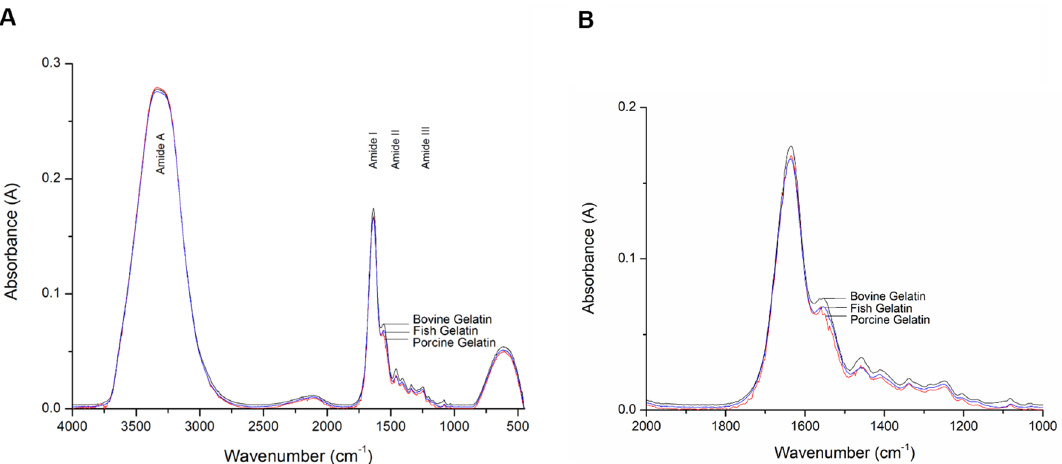
Figure 3. ( A ) Full scale FTIR spectra of bovine, porcine and fish gelatins and ( B ) enlarged spectra of bovine, porcine and fish gelatins at 2000–1,000 cm -1